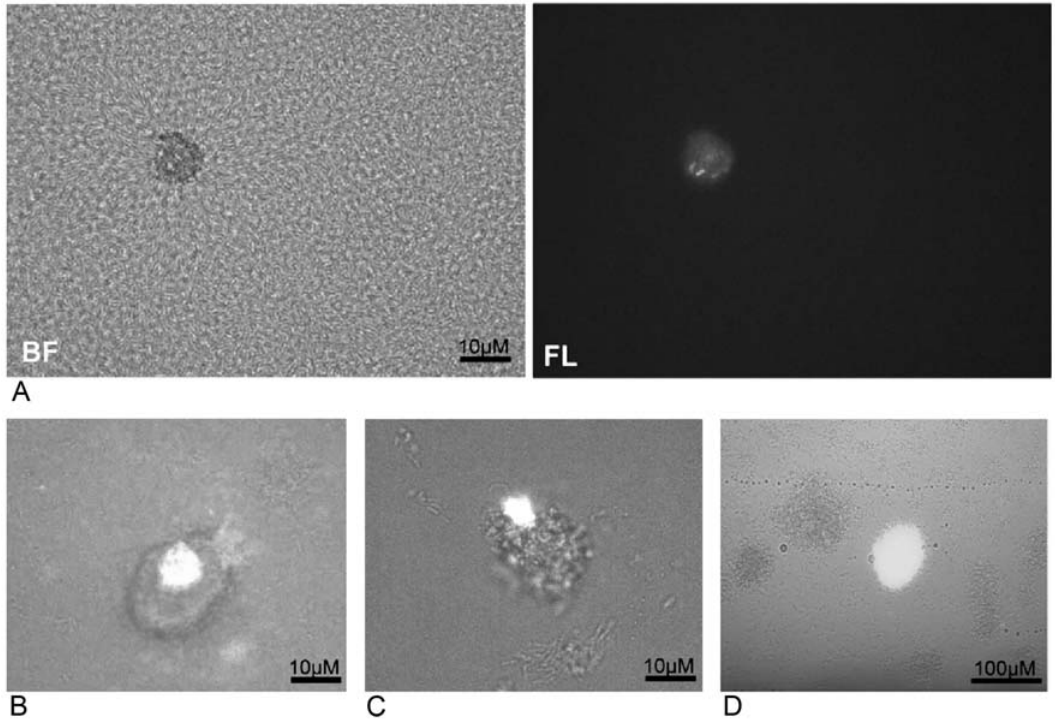
Figure 1. GFP fluorescence-inducing mutations (FIMS) occur during P.aeruginosa pMDGFP biofilm development. FIMS were observed exclusively within microcolony structures, but not within unstructured ‘carpet’ regions of the biofilm as in (A), which shows bright field (BF) and fluorescence (FL) images of the same field of view. FIMS were observed as individual GFP-expressing cells (A), or as clusters of GFP cells within microcolonies possibly due to clonal expansion following GPF reversion (B, C). Microcolonies comprised wholly of GFP-expressing cells were occasionally observed (D).